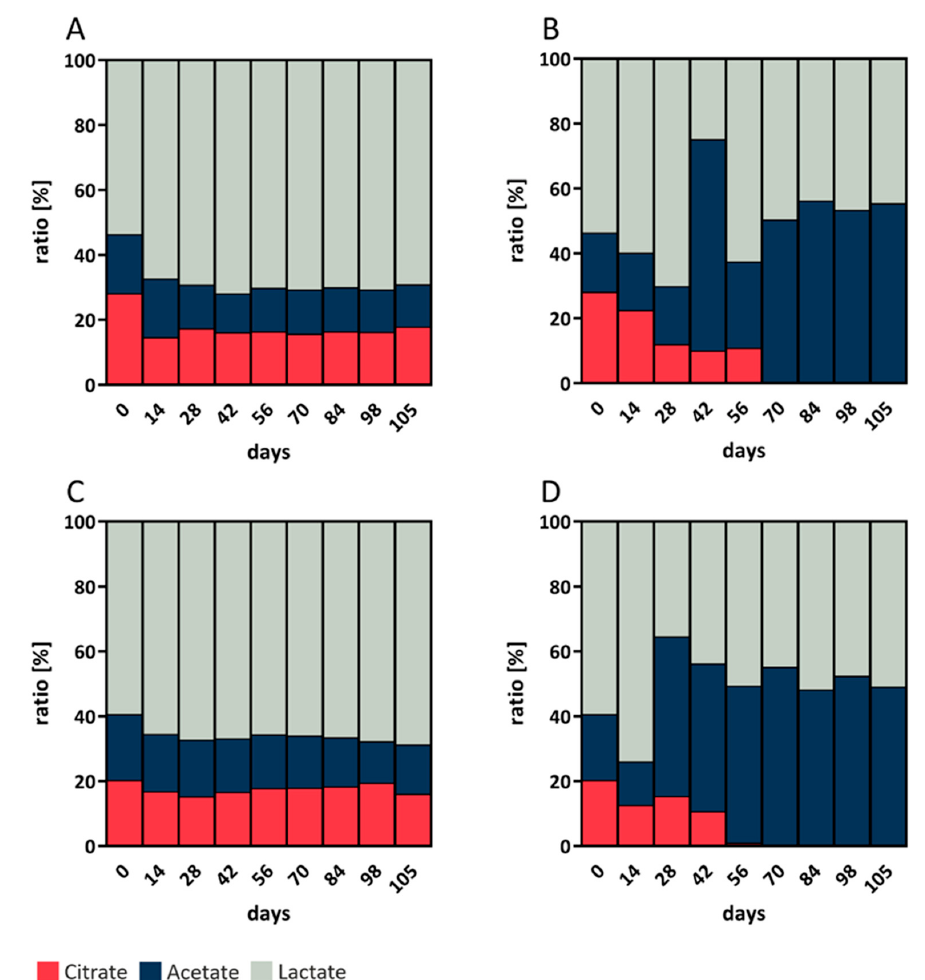
Figure 2. Acetic acid, citric acid, and lactic acid ratios of sourdough. ( A ) Wheat sourdough; 4 °C; W700. ( B ) Wheat sourdough; 10 °C; W700. ( C ) Rye sourdough; 4 °C; R960. ( D ) Rye sourdough; 10 °C; R960.